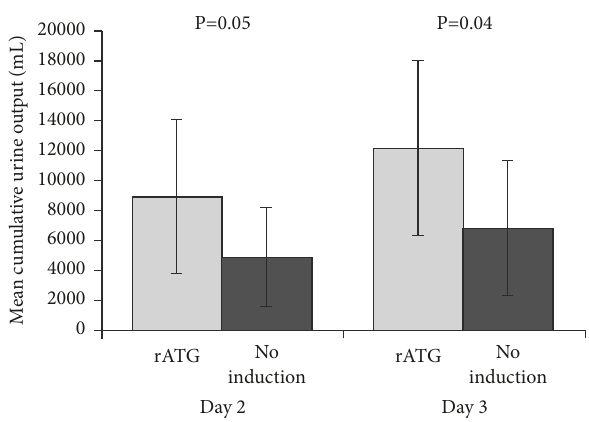
Figure 2: Cumulative urine output at day 2 and day 3 after kidney transplantation in patients receiving rabbit antithymocyte globulin (rATG) (n=7) versus no induction (n=11), with calcineurin inhibitor therapy initiated based on renal function, mycophenolate mofetil (MMF) and steroids [42]. Values are shown as mean